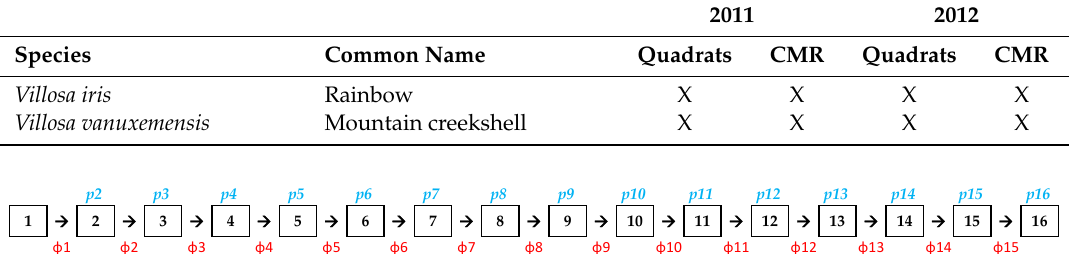
Figure A1. Cormack–Jolly–Seber (CJS) open-capture model diagram for Epioblasma capsaeformis at